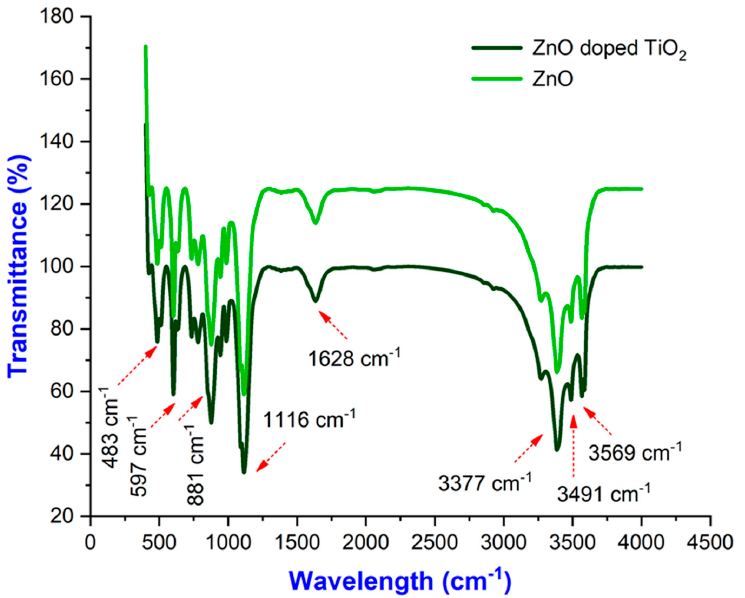
Figure 5. Doped TiO 2 nanocomposites synthesized with pure ZnO as the doped component are shown in the FTIR spectrum.